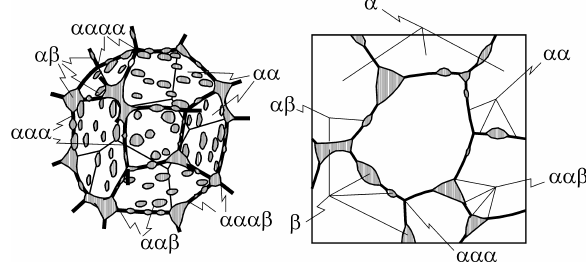
Figure 2. Microstructure with β phase particles distributed on the grain boundary network in the α phase, displaying αα and αβ interfaces, and ααα and ααβ triple lines.